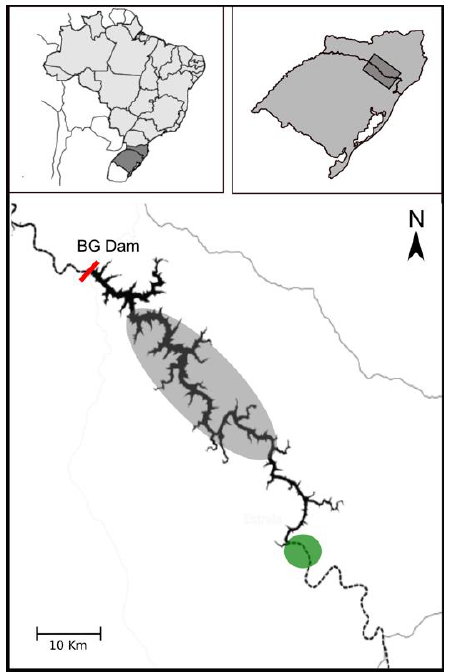
Figure 1. Map of the study area. Barra Grande Dam is represented by the red line. Fish release site and recapture area are outlined in green and grey respectively.